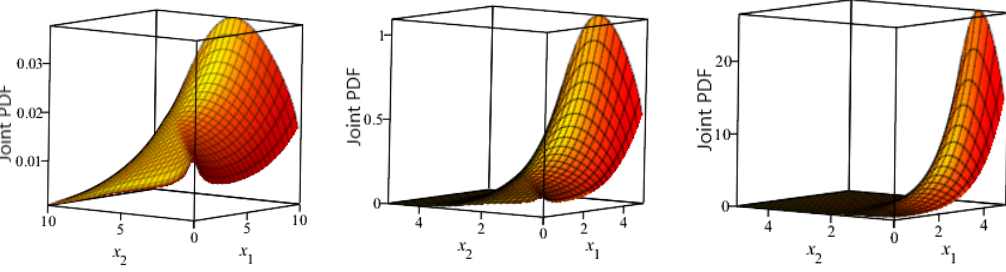
Figure 1. The surface plots of the joint probability density function (PDF) for γ 1 = γ 2 = γ 3 = 0.3 and a = 0.1, 0.3 and 0.5, respectively.